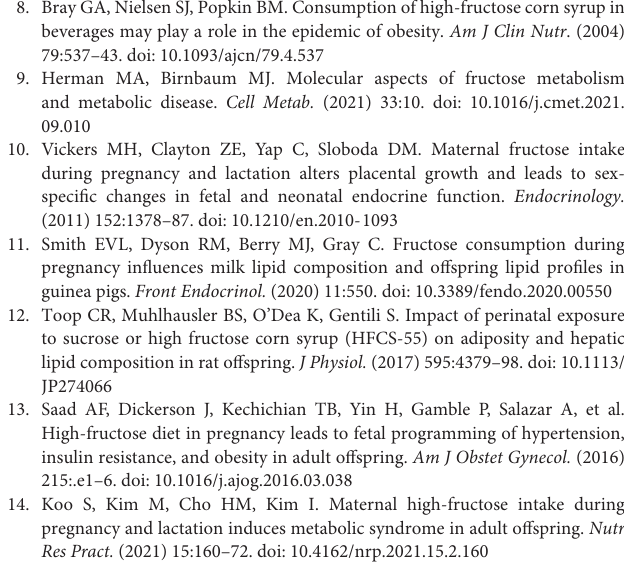
Supplementary Figure 1 | The effects of maternal high-fructose intake during pregnancy on adult offspring fed with a chow diet (CD). All data were from the CD-fed control offspring and HF offspring. (A) Bodyweight curve of the offspring. (B,C) Relative body composition of the offspring. (D) Tissue weights of the offspring. (E) H&E staining of paraffin sections of inguinal white fat (iWAT), epididymal white fat (eWAT), and liver. Scale bar, 100 µ m. (F) Quantification of average adipocyte area from images depicted in (E) . (G) Quantification of triglyceride (TG) content in liver ( n = 8). (H,I) Plasma concentrations of TG and total cholesterol (TC) ( n = 8). (J) Blood glucose concentrations during glucose tolerance test ( n = 6). (K) Quantification of the area under the curve of (J) . (L) Blood glucose concentrations during insulin tolerance test ( n = 6). (M) Quantification of the area under the curve of (L) . * p < 0.05, ** p < 0.01. Supplementary Figure 2 | Maternal high-fructose intake during pregnancy does not affect energy expenditure in adult offspring with a chow diet. All data were from the 17-week-old CD-fed control offspring and HF offspring. (A) Daily food intake of the mice ( n = 5). Indirect calorimetry analysis of day and night